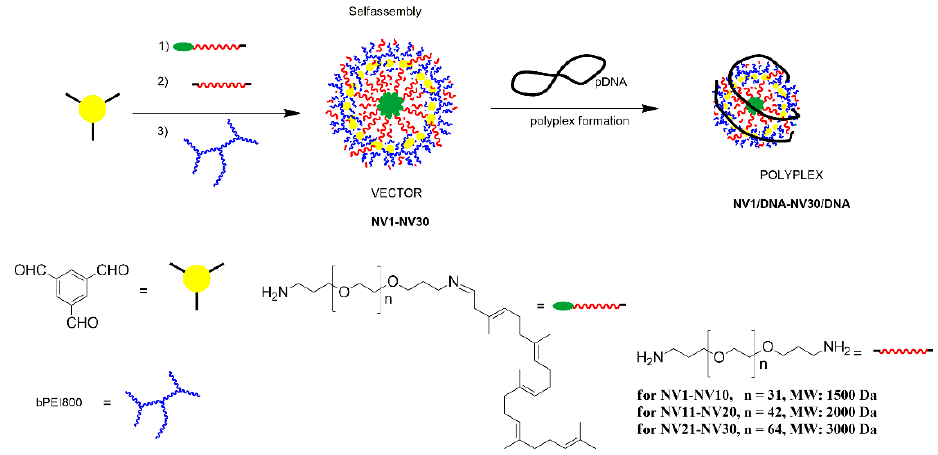
Figure 1. Schematic representation for the formation of vectors NV1–NV30 and polyplexes.